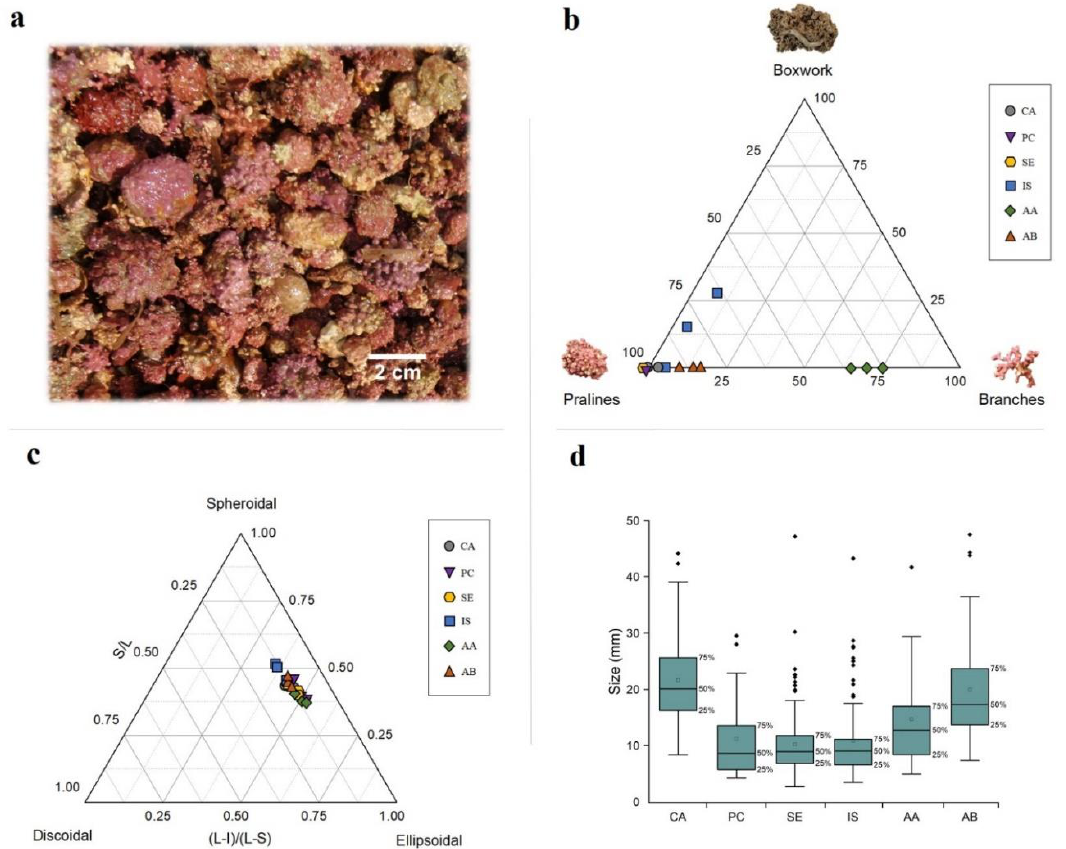
Figure 6. Collected rhodoliths and graphic analyses of their morphology, shape, and size. ( a ) Detail of collected rhodoliths from MS18-CA1 sampling, from Capri Island, 59 m depth. ( b ) Ternary plot of the main morphotypes (i.e., pralines, boxwork rhodoliths, and unattached branches). Each symbol indicates one of the three random samplings collected within each site. ( c ) Shape classification of rhodoliths using Sneed and Folk’s pebble shape diagram [82]. Long (L), intermediate (I), and short (S) axes of rhodoliths. ( d ) Box plot showing size range of rhodoliths calculated as the volume of an ellipsoid, following [8]; hence, unattached branches were not considered for size measurements. n = 120, except Acciaroli A, where n = 45. CA, Capri; PC, Punta Campanella; SE, Secchitiello; IS, Ischia; AA, Acciaroli A; AB, Acciaroli B.